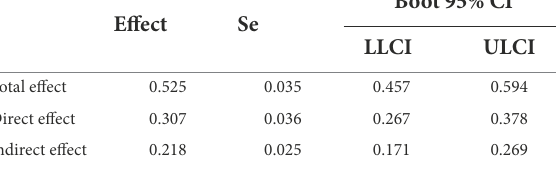
TABLE 3 Bootstrapping test results for mediating